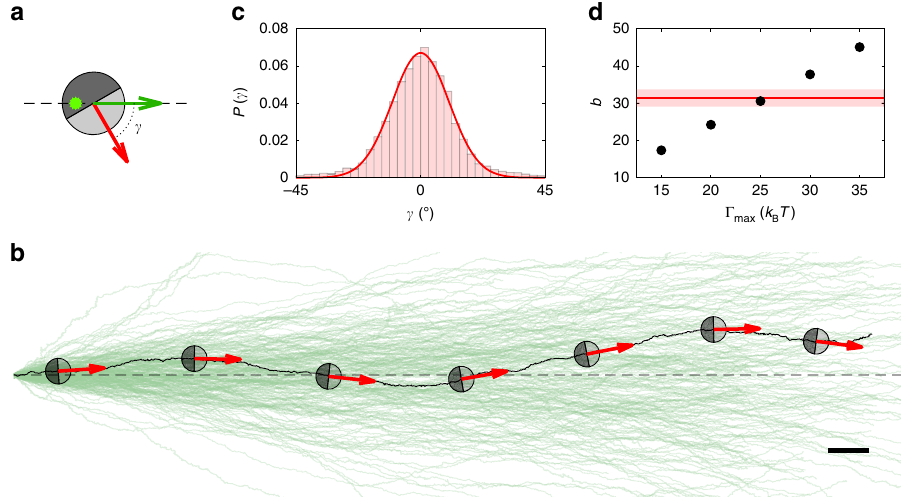
Fig. 6 Calibration of AP reorientation. a Sketch of the experimental situation to measure active torques on an AP. The illuminating laser spot (green symbol) is displaced by 0.3 σ opposite to the steering direction (green arrow). This causes a torque on the particle, leading to alignment of the current particle orientation (red arrow) with the steering direction. b Measured particle trajectories (green) when APs are steered along a straight path to the right (dashed line). Scale bar is 10 μ m. c Measured probability distribution of γ (coloured bars). In principle, γ can be measured by the optical contrast due to the light-absorbing carbon cap. This, however, leads to relatively large errors in γ . Therefore, γ has been obtained from the swimming direction averaged over 20 s. The solid line corresponds to a fi t to P ( γ ) = a exp ( b ⋅ cos( γ )). d Fit parameter b as obtained from simulated trajectories according to the same protocol as shown in a . To compare the experimental P ( γ ) with that obtained from numerical simulations, we fi rst computed AP trajectories for different maximal torques Γ max . Following the identical evaluation procedure of γ as for the experimental data, this yields the parameter b which is shown here (symbols). Best agreement of the b -value of the experimental data (red line) is obtained for Γ max = 25 k B T . The coloured band corresponds to the standard deviation of 6 independent of their swimming direction due to rotational diffusion. When subjected to a local opposite to the target direction ^ d (Fig. 6a) This results in a torque Γ max ≈ 25 k B T , light gradient ∇ I , however, the AP ’ s mean orientation (i.e., swimming direction) which corresponds to a rotation rate ω max ≈ 4° s − 1 (see also below). becomes aligned opposite to ∇ I 45 . This is due to the inhomogeneous heating of the carbon cap, which leads to an asymmetry of the fl uid ’ s fl ow fi eld around the AP Characterisation of the orientational steering of APs . Under homogeneous relative to its orientation ^ u . This results in a torque Γ / ∇ I ´ ^ u on the AP, which particle illumination, APs self-propel with constant velocity and random changes